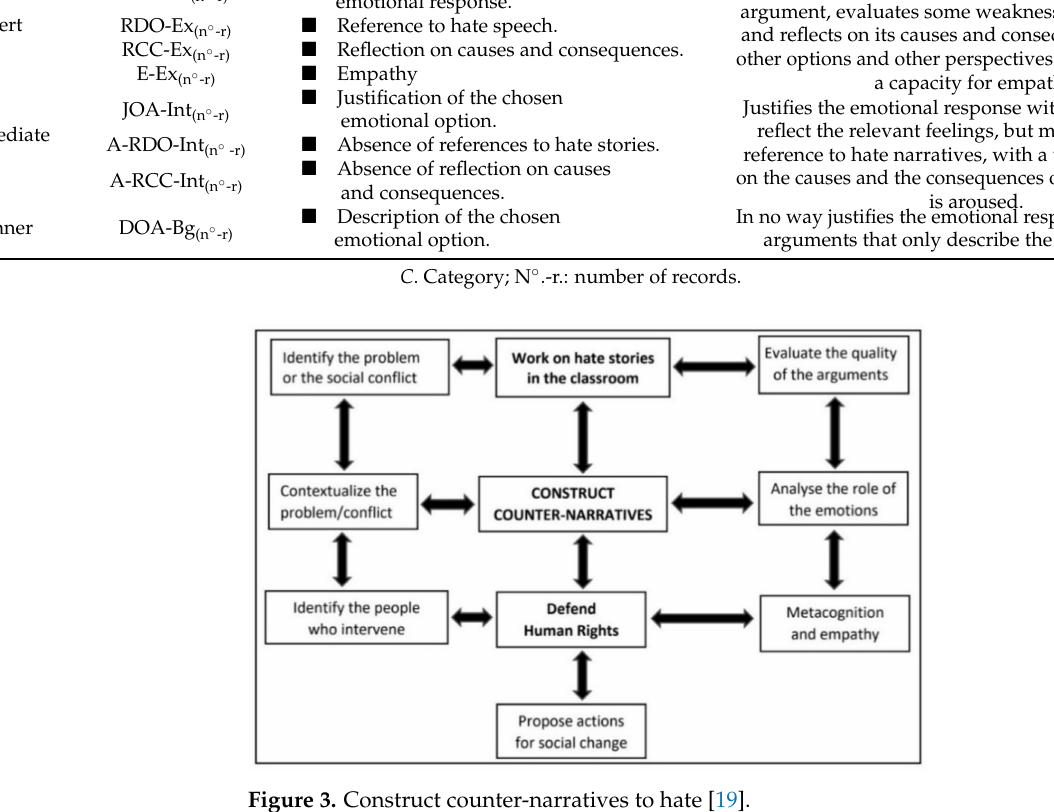
Figure 3. Construct counter-narratives to hate